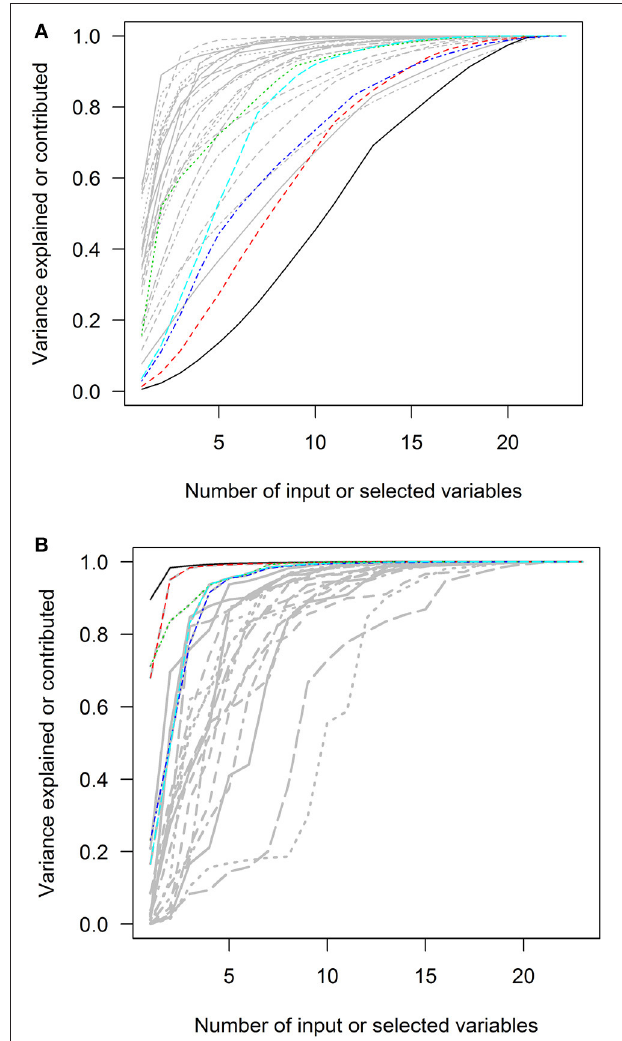
FIGURE 6 | The squared loadings in each PC and the R squared of PC approximation in the Canadian Health Measures Survey spirometry subset. (A) The squared loadings of all variables in PCs. (B) The adjusted R squared of the variables that were used to approximate PCs. PC, principal component. Black, first PC; red, second PC; green, third PC; blue, fourth PC; light blue, fifth PC.